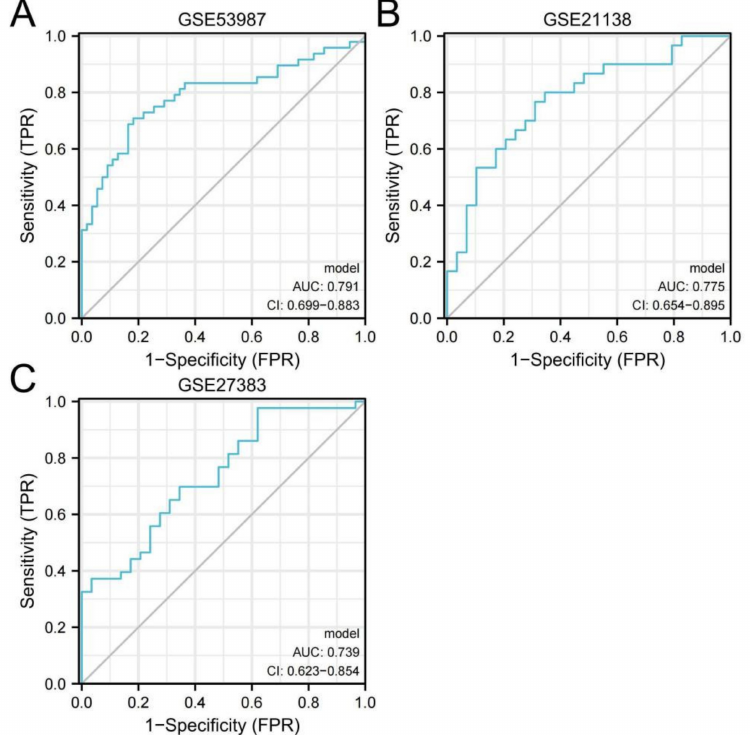
Figure 14. Diagnostic evaluation of joint indicators from three datasets. ( A ) GSE53987; ( B ) GSE21138; ( C )